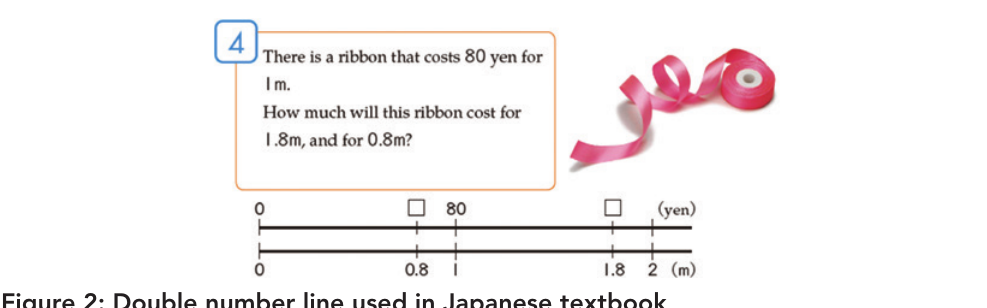
Figure 2: Double number line used in Japanese textbook Source: Hironaka and Sugiyama (2006b: